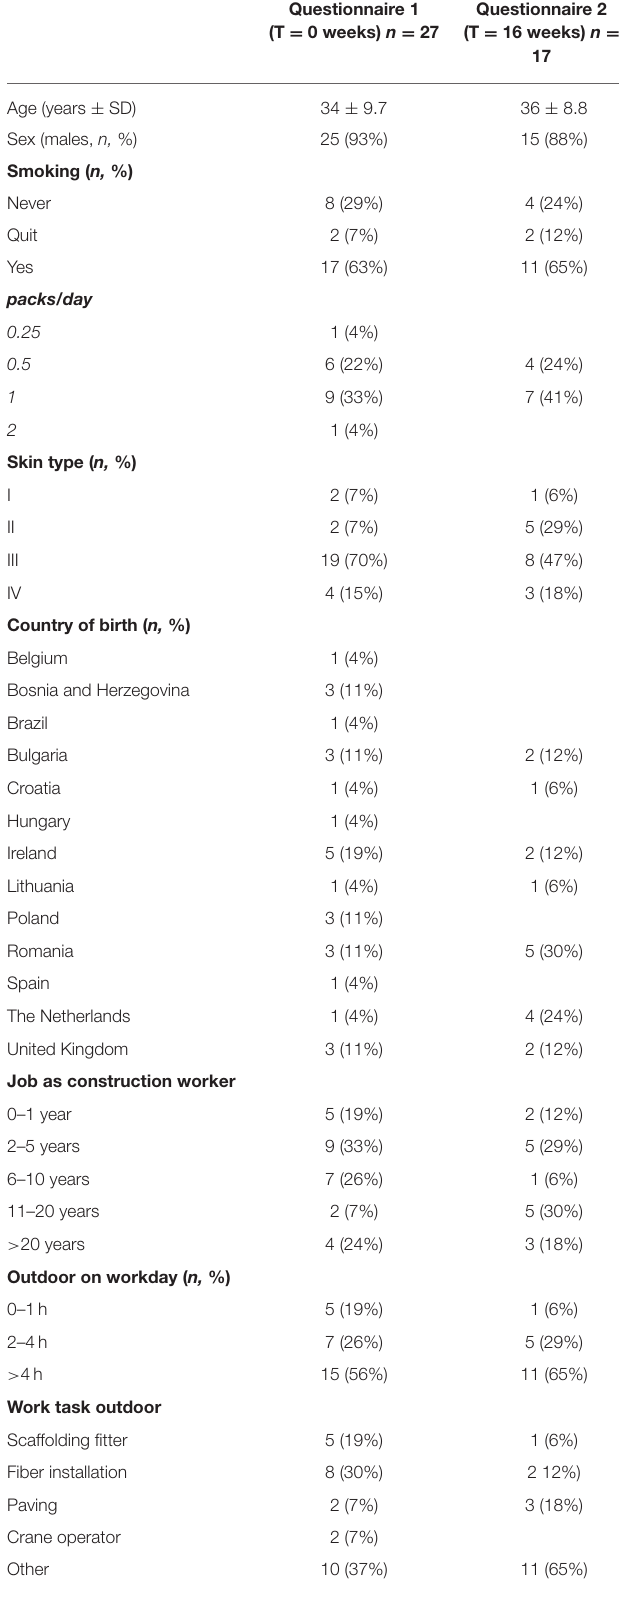
TABLE 1 | Background characteristics of outdoor